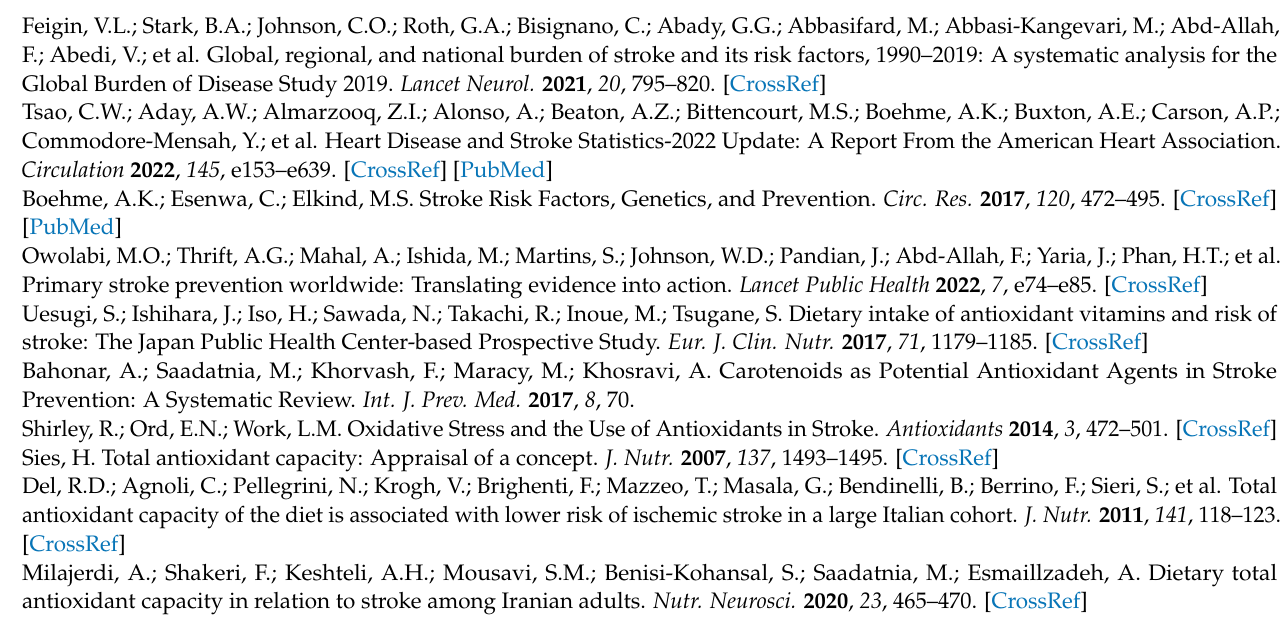
study; Table S3: Intake of antioxidant vitamins between participants with stroke and without stroke; Table S4: Characteristics of the participants by weighted tertile of total antioxidant capacity among US adults; Table S5: Relationship between each antioxidant vitamin and stroke; Table S6: Relationship between eight antioxidant vitamins and stroke; Table S7: Sensitivity analysis of relationship between total antioxidant capacity and risk of stroke after exclusion of participants with